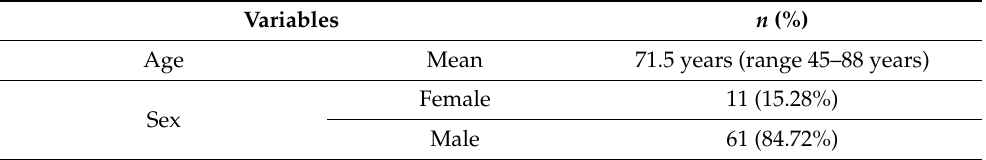
Table 1. Clinicopathological characteristics of the study